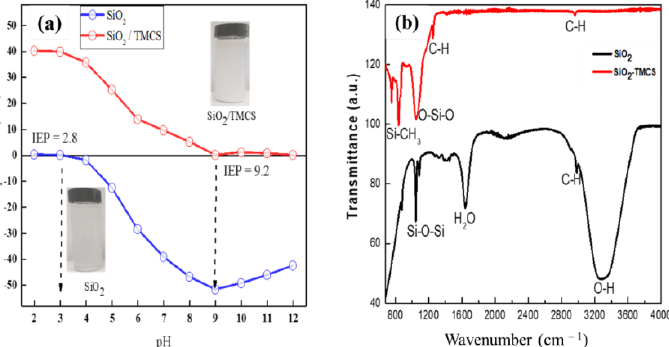
Figure 3. Isoelectric point ( a ) and FTIR ( b ) of SiO 2 NPs and SiO 2 /TMCS film. As shown in Figure 3b, broad absorption bands at 3400 cm −1 and 1620 cm −1 corre- sponded to the –OH groups adsorbed at the SiO 2 surface in the FTIR spectrum. The broad